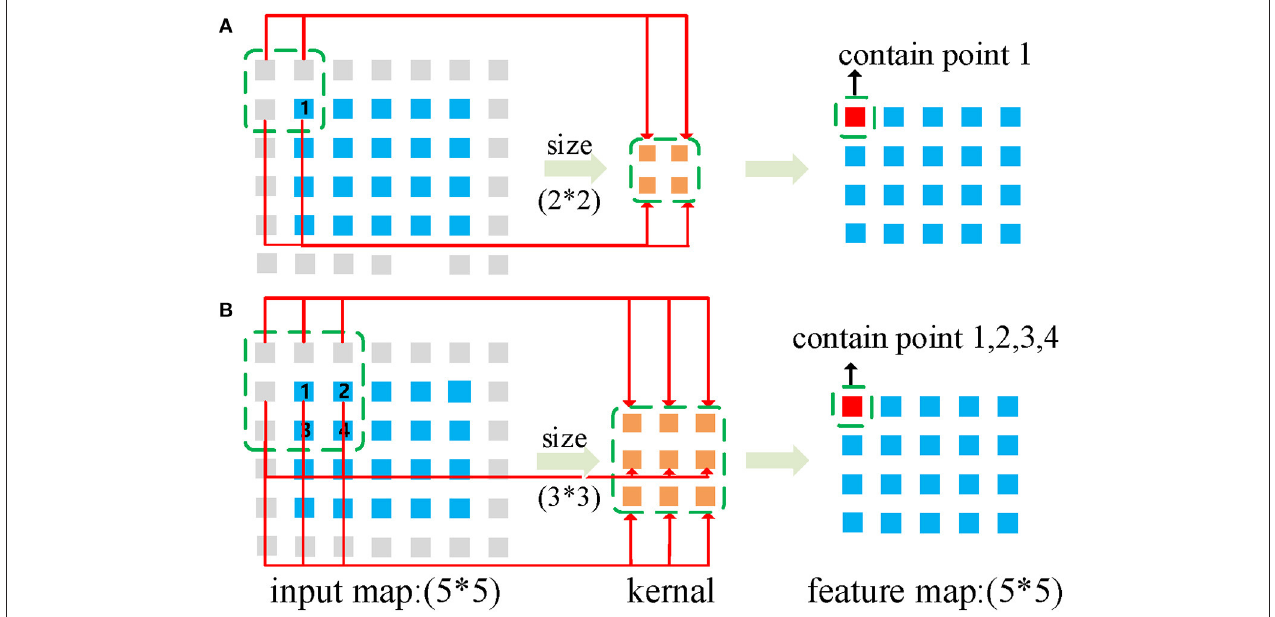
FIGURE 1 | Receptive field: same input and different convolutional kernel. The gray squares represent the padding. (A,B) illustrate how the input map converts the output (feature map) through a convolution operation with 2 × 2 and 3 × 3 kernels, respectively.